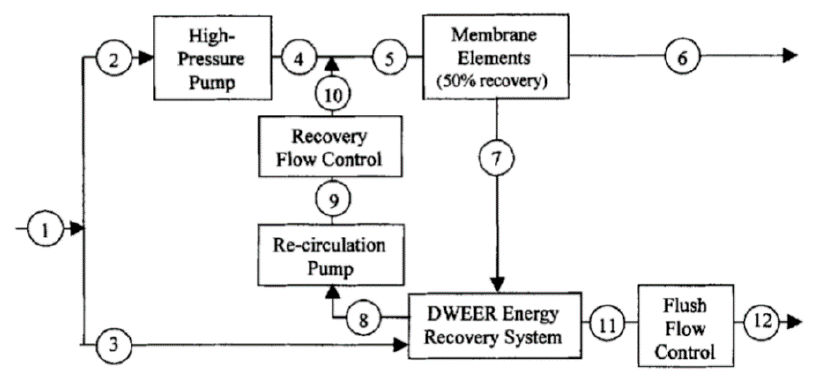
Figure 5. SWRO unit process (DWEER TM ) [ Error! Reference source not found. ].